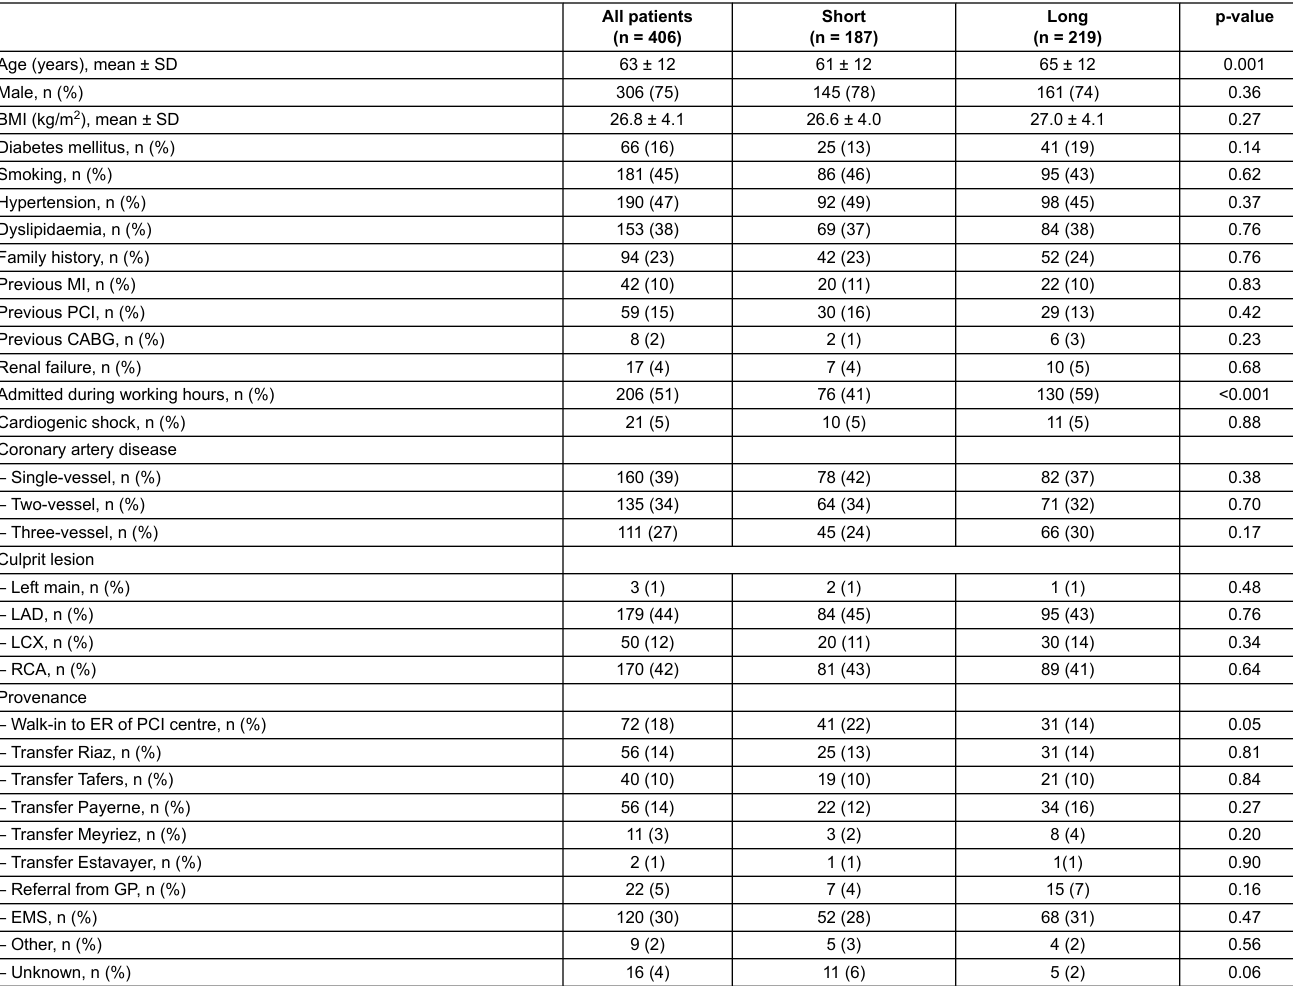
Table 1: Baseline patient characteristics.